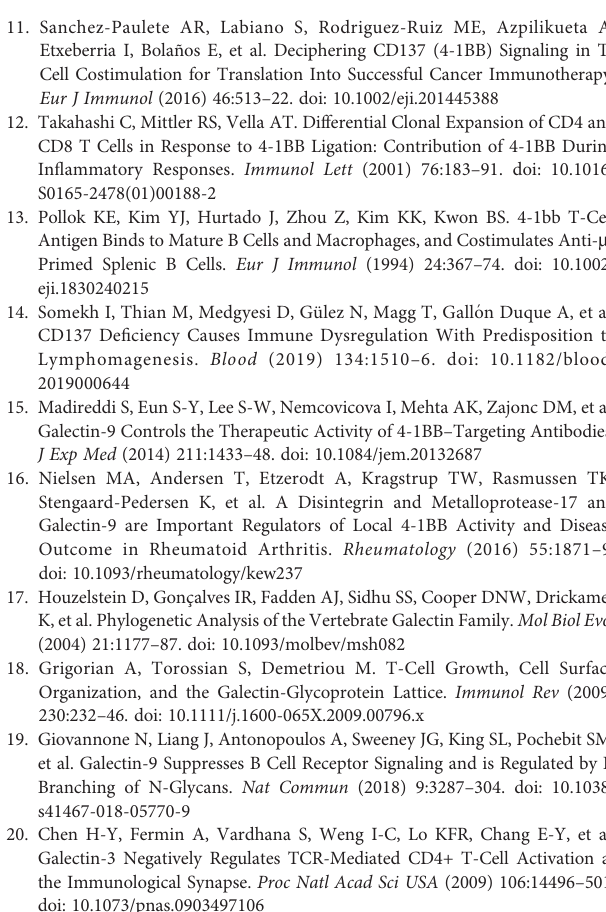
Supplementary Figure 5 | Gating strategy for permeabilized human CD3/CD28- activated CD4 T cells intracellularly stained for TNF a . (A) Live, single cells were tested for co-expression of 4-1BB and TNF a , gates based on FMOs, evaluated with, or without, incubation in HC plasma for 30 min. (B) 4-1BB+ HEK293 cells were stained for Gal-3 expression after incubation in in HC plasma for 30 min. Live, single cells were evaluated for 4-1BB and Gal-3 expression, gates were again based on FMOs. Gal-3+ were only seen on 4-1BB+ HEK293 cells (Blue). Supplementary Figure 6 | (A) The glycosylated extracellular matrix proteins (ECM) were printed on microarray slides coated with nitrocellulose. Human Galectin-3 were tested with 20 m g/mL. The error bars (Black) represent the SD among the values of four replicate spots. Reported Gal-3 binding is marked by transparent bars. The probes are grouped as indicated in the colored panels. The binding signals were directly quanti fi ed and displayed as mean relative fl uorescence intensity (RFU). Supplementary Figure 7 | Co-incubation of CD4+, 4-1BB+ T cells with plasma from healthy controls on a laminin coated or uncoated surface for 30 min. before being stimulated with orwithout 4-1BBL. Encountering alaminin coated surface did not led to increased TNF a production in the 4-1BB+ CD4+ T cells. Further laminin did not indirectly inhibit the effect of 4-1BBL stimulation on 4-1BB+ CD4+ T cells. (A) In the fi rst and second bar, activated CD4 + , 4-1BB + T cells with plasma from healthy controls were cultured on a laminin coated or uncoated surface for 30 min. beforebeingstimulated with4-1BBL(n=5).Inthethirdbar,co-incubationofCD4+, 4-1BB+ T cells with plasma from healthy controls on a laminin coated surface with or without 4-1BBL stimulation (n = 4). Bars represent mean (SEM) as the fraction of TNF a producing 4-1BB+ CD4 T cells. Second bar represents a ratio of cells cultured with laminin compared to without laminin prior to 4-1BBL stimulation.